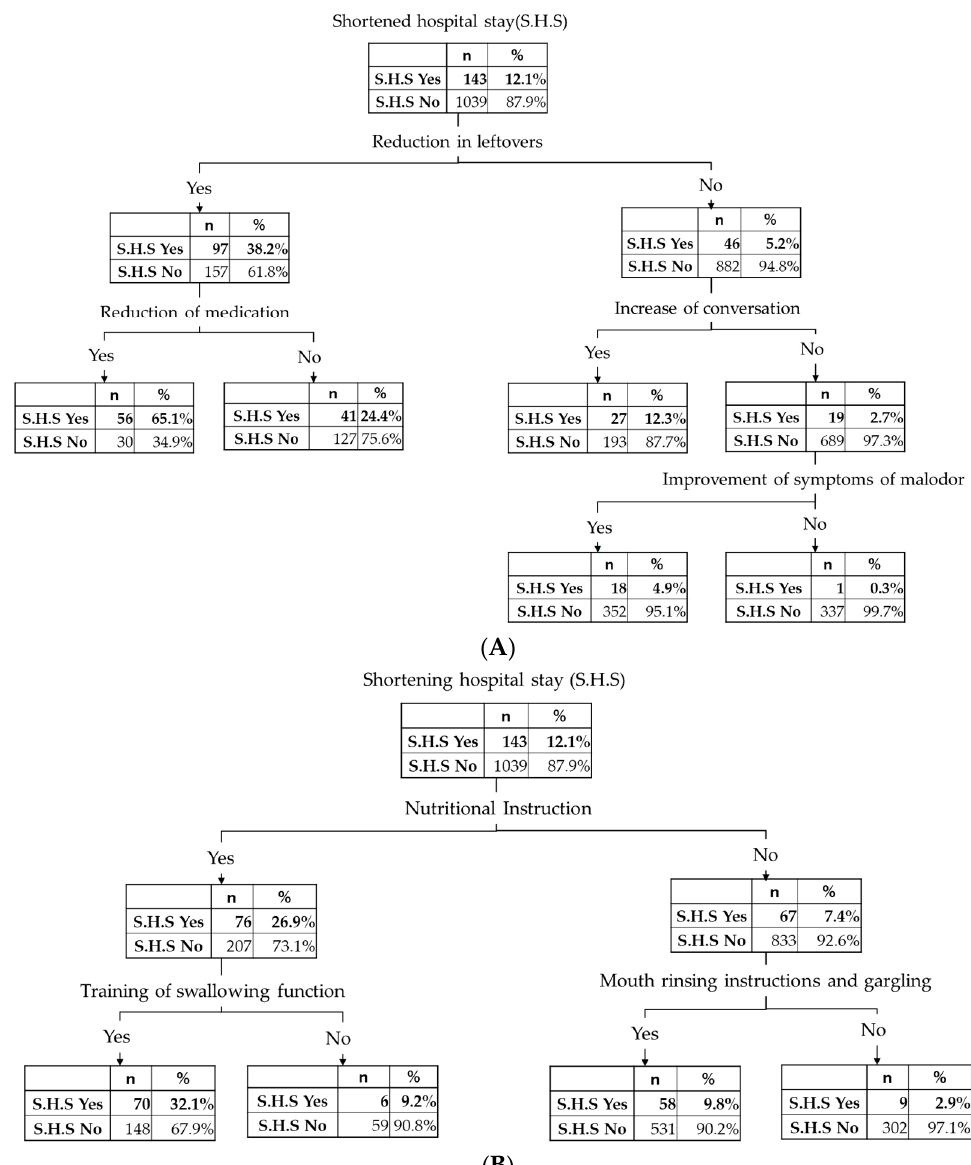
Figure 3. Decision trees used to determine processes and effects leading to a shortened hospital stay: ( A ) treatment that led to a shortened hospital stay; ( B ) self ‐ assessed effects of perioperative oral care management that led to a shortened hospital stay. Subjects who did not answer for the item of shortened hospital stay were excluded from the analysis.